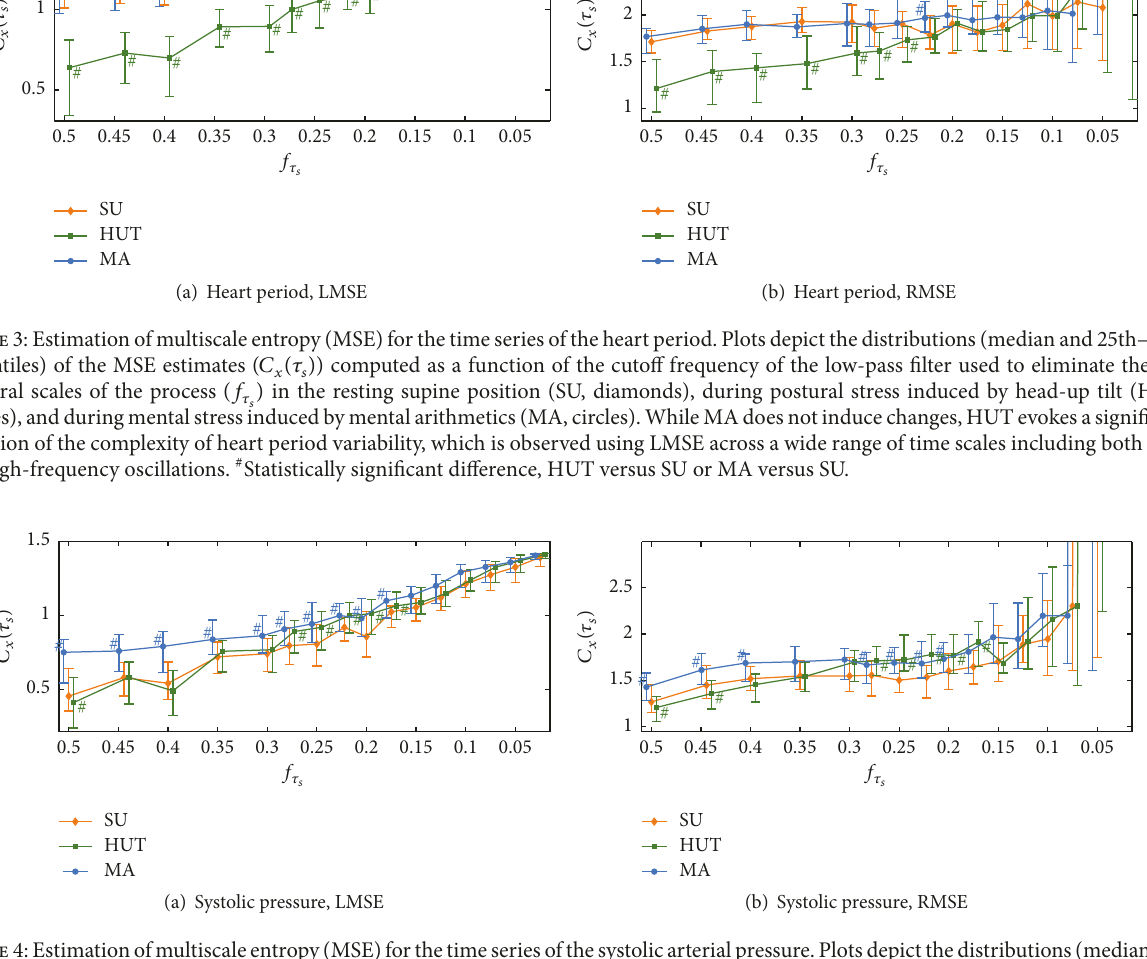
Figure4:Estimationofmultiscaleentropy(MSE)forthetimeseriesofthesystolicarterialpressure.Plotsdepictthedistributions(medianand 25th–75th percentiles) of the MSE estimates (𝐶 𝑥 (𝜏 𝑠 ) ) computed as a function of the cutoff frequency of the low-pass filter used to eliminate the ) in the resting supine position (SU, diamonds), during postural stress induced by head-up tilt (HUT, fast temporal scales of the process (𝑓 𝜏 𝑠 squares), and during mental stress induced by mental arithmetics (MA, circles). The multiscale complexity of systolic pressure dynamics increases consistently across multiple time scales during MA and increases for time scales associated with low-frequency oscillations during HUT. # Statistically significant difference, HUT versus SU or MA versus